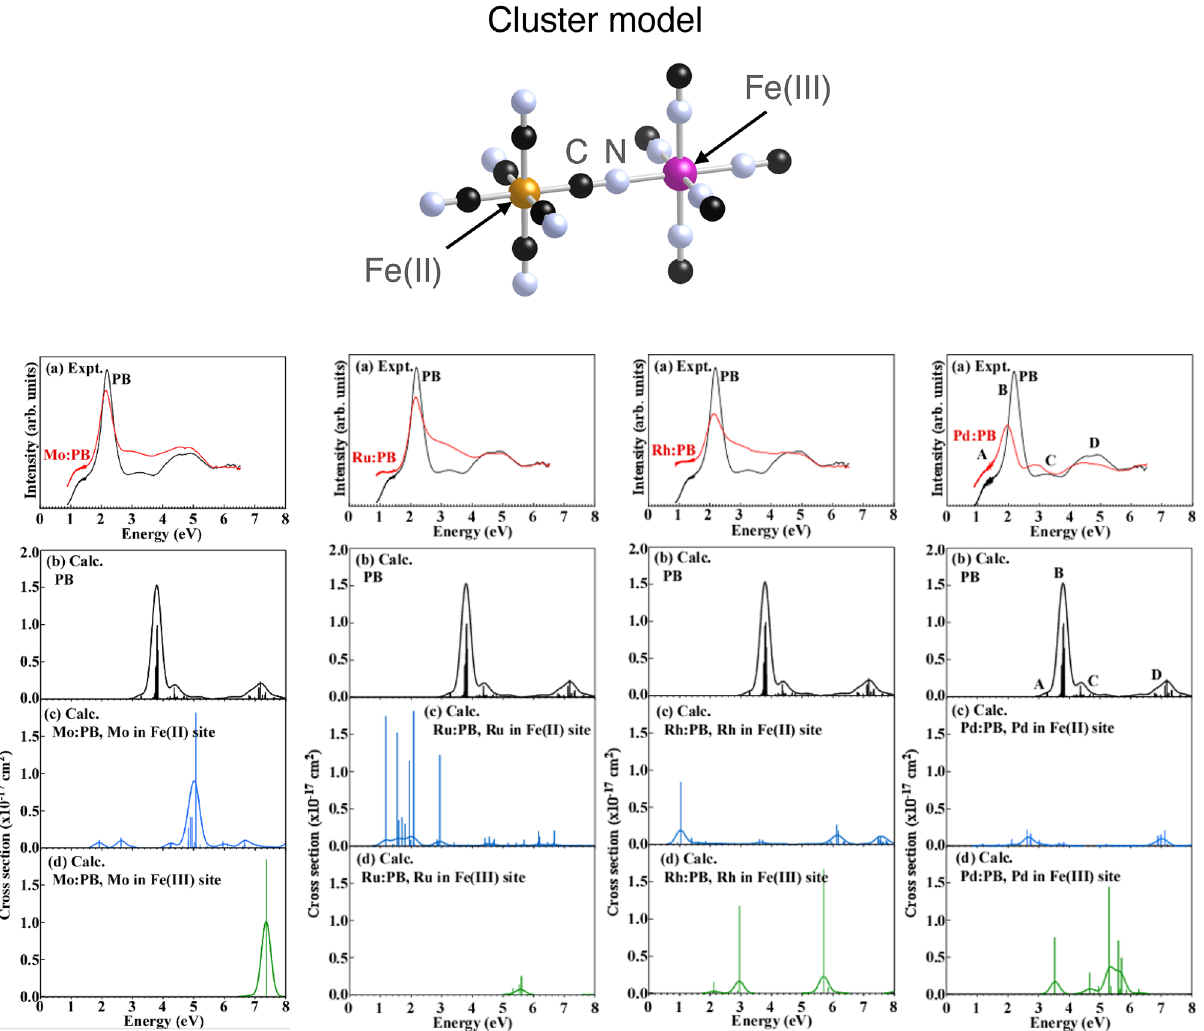
Figure 1. Theoretical spectra of the pristine ( b ) and PGMs/Mo-sorbed PB using the cluster models for Fe 2+ ( c ) and Fe 3+ ( d ) substitution, along with the experimental UV–vis-NIR spectra of PB before (black) and after (red) PGMs sorption ( a